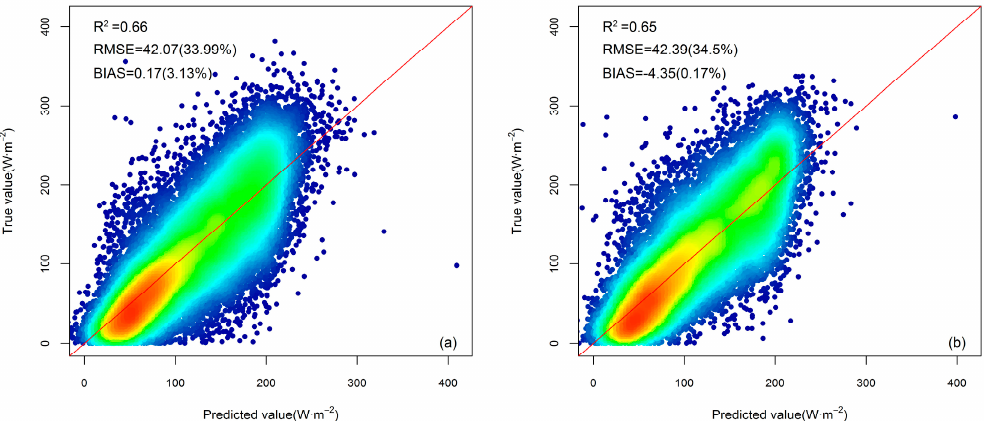
Figure 11. ( a ) Evaluation results of the training dataset’s daily estimated DSR based on the ANN-based cloudy sky model against ground measurements in 2001 and 2002. ( b ) Evaluation results of the validation dataset’s daily estimated DSR based on the ANN-based cloudy sky model against ground measurements in 2003. The number in the parentheses is the percent bias or RMSE value. Table 3. Comparison of the results of the ANN and GBRT models at a daily time scale (using measurements from 2001 and 2002 as the training dataset and measurements from 2003 as the validation dataset). The number in the parentheses is the percent bias or RMSE value. Dataset Sky Condition